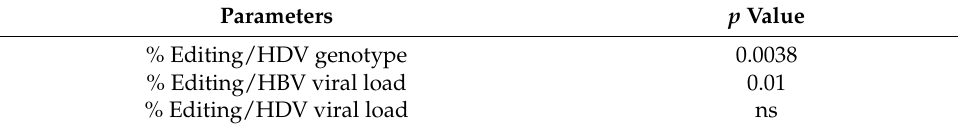
Table 1. Pearson test correlation analysis performed with R (version 3.5.1, 2018).